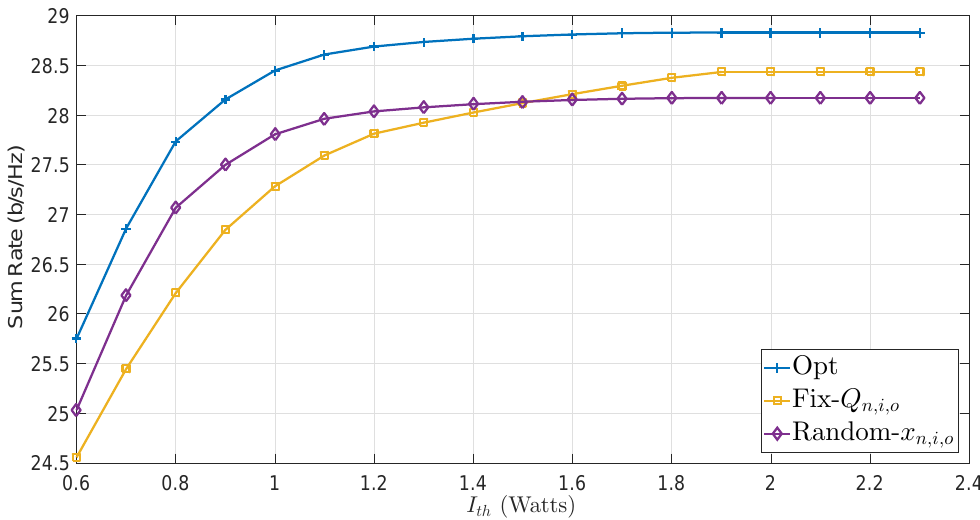
Figure 5. A comparison of sum rate offered by each scheme for increasing P T .